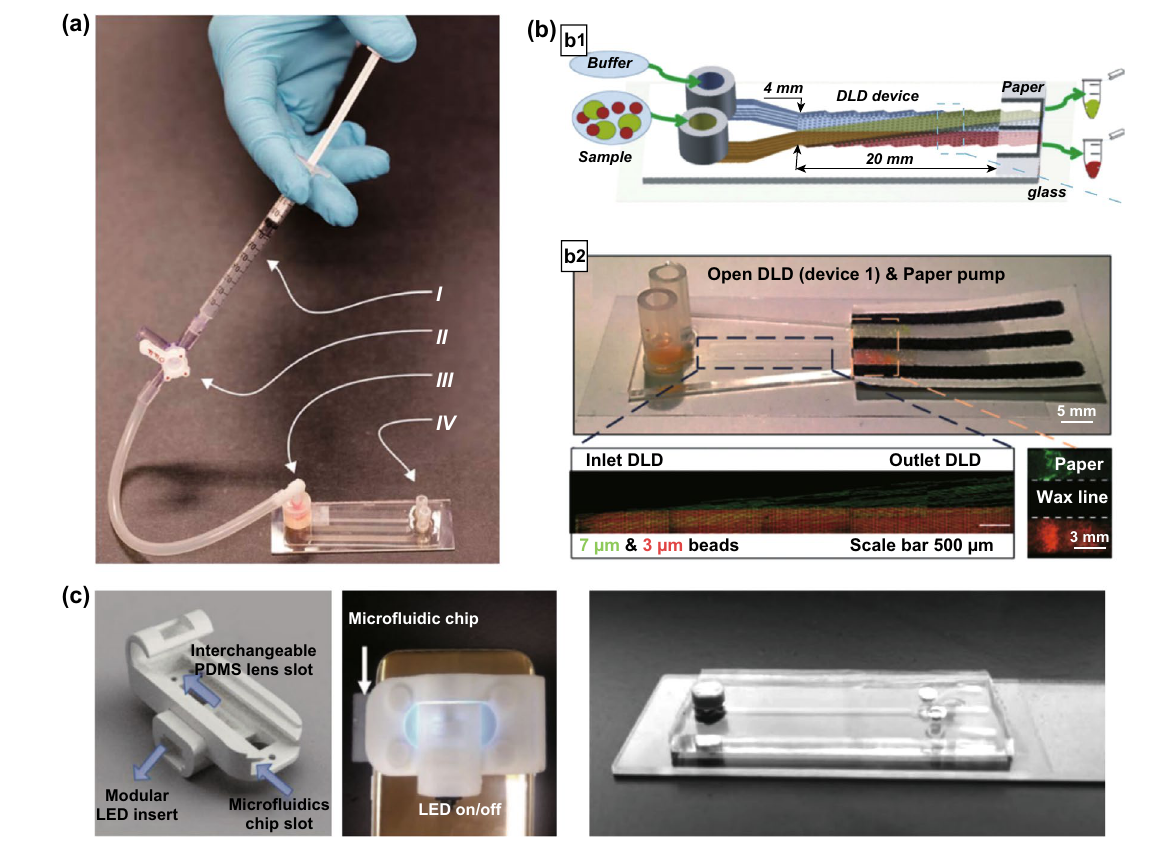
Fig. 14 Simplification of DLD setups for particle separation. a The use of a simple disposable syringe-based pump to drive the fluid in micro- fluidic DLD [17]. b The application of paper pump to drive the particle separation in an open DLD channel [69]. c A portable smartphone-based platform for moving beads detection in microfluidic DLD [93]. Figure panels reproduced from Ref. [17] with permission from the Royal Society of Chemistry (CC BY 2016), Ref. [69] with permission from the Royal Society of Chemistry (CC BY 2017), Ref. [93] with permission